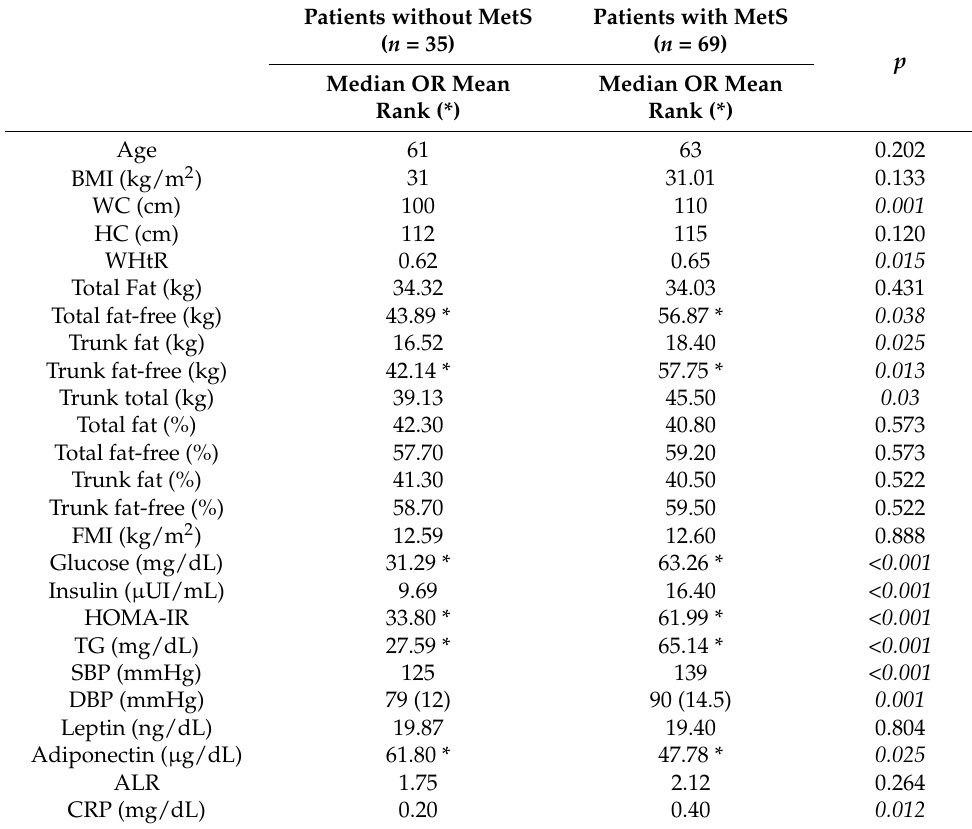
Table 2. Comparison of parameters between the group with MetS and the group without MetS.